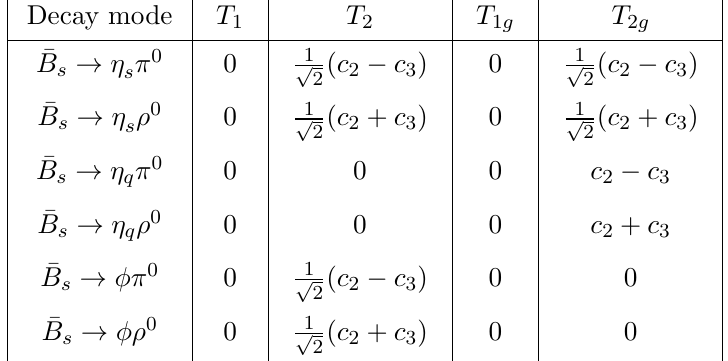
Table 1 . Hard kernels T r = 1 ; 2 are obtainable from T